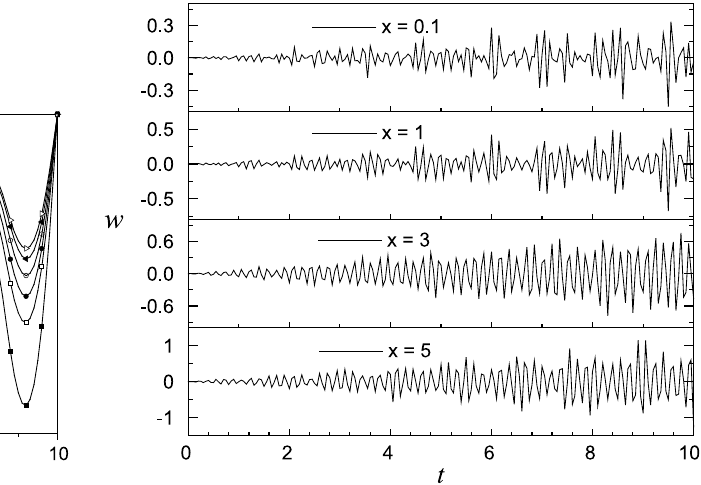
Fig. 17. Deflection of various points for the simply supported FGPM cylin- drical shell imposed by a uniform mechanical load as the time increasing, when n = 1 .